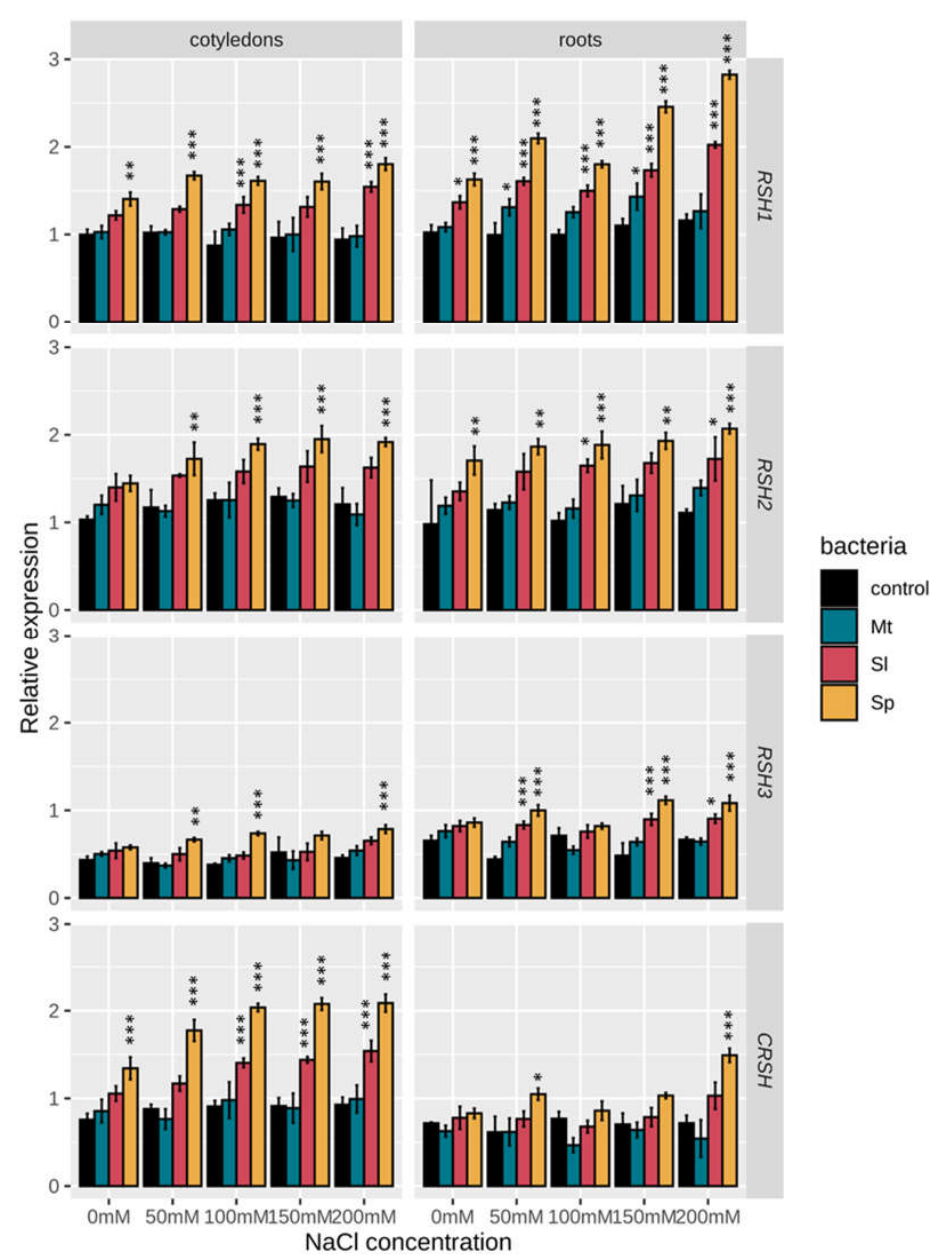
Figure 8. Expression analysis of BnRSHs in salt stress and in the presence of PGPR bacteria using sqRT-PCR. Charts show the relative transcript level of BnRSH1_b , BnRSH2_b , BnRSH3_a , and BnCRSH genes with respect to the expression of a reference gene ( BnAc ). Bars represent means ± SD. Control (black bars) are plants grown in in different NaCl concentrations (0 mM, 50 mM, 100 mM, 150 mM, and 200 mM NaCl) but without inoculation with bacteria. Mt (green bars)— M. timonae , Sl (red bars)— S. liquefaciens , Sp (yellow bars)— S. plymuthica . Statistical analysis was performed using two-way ANOVA followed by Scheffe post-hoc test. Asterisks indicate statistically significant differences in comparison to the control (i.e., expression of a particular RSH gene in plants grown in the same concentration of salt but without bacteria—black bars) at p -value < 0.001 (***), p -value < 0.01 (**), and p -value < 0.05 (*). Full statistical analysis data are available as Supplementary Materials (Supplementary Tables